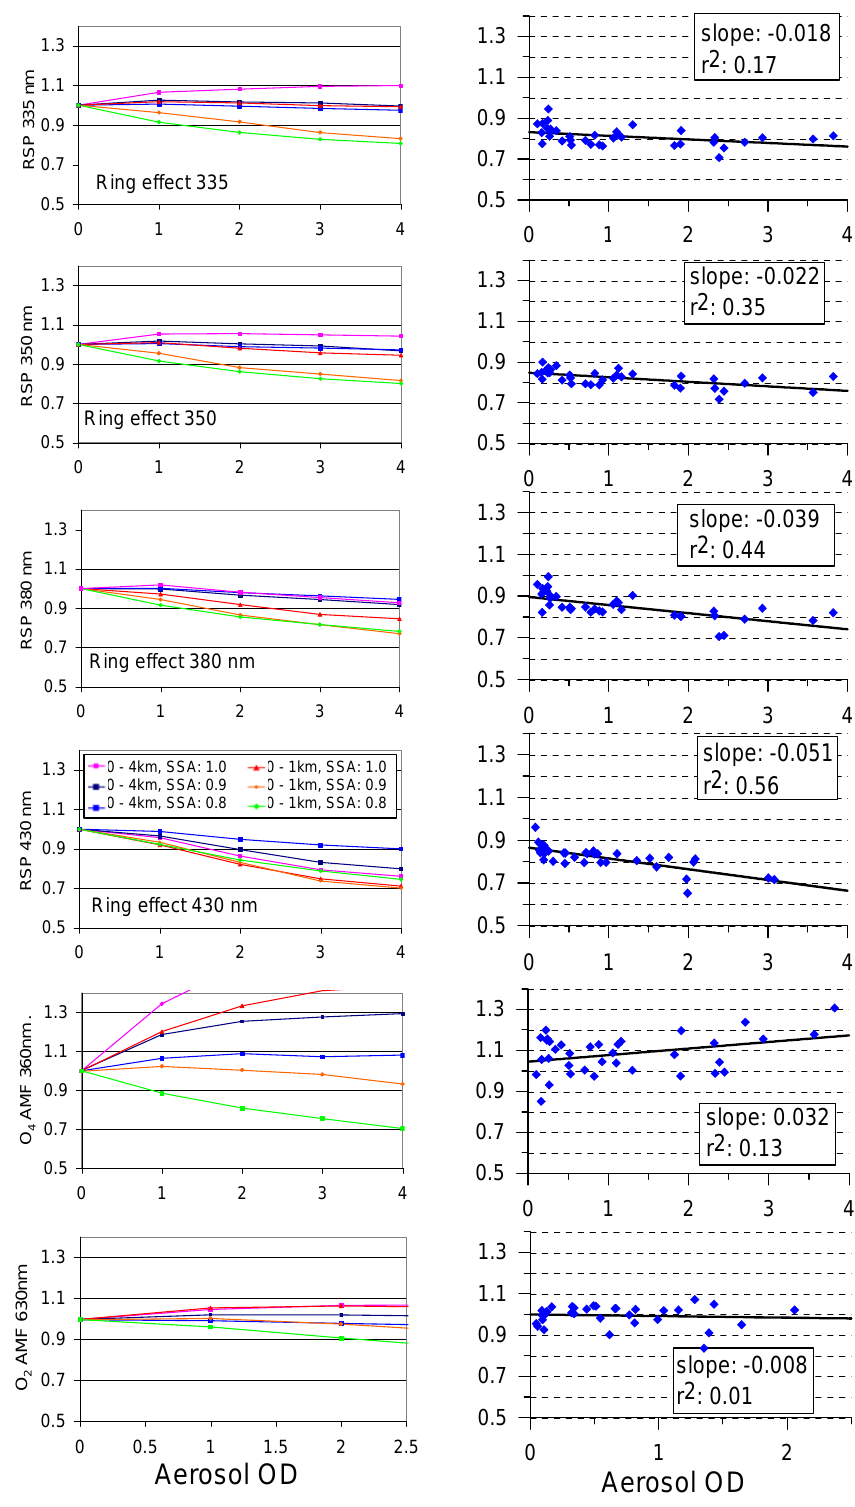
Fig. 12 Observed (right) and simulated (left) dependence of the Ring effect and the O Fig. 12. Observed (right) and simulated (left) dependence of the Ring effect and the O 2 and O 4 absorptions on the AOD. The data are absorptions on the AOD. The data are normalised to model results for an AOD of 0 (see text). normalised to model results for an AOD of 0 (see text). The calculations are performed for SZA of 30 ◦ and a viewing angle of − 90 ◦ (nadir). The calculations are performed for SZA of 30° and a viewing angle of -90° (nadir). The The aerosol asymmetry parameter was assumed to be 0.68. For 630nm the surface albedo was set to 10%; for all other wavelengths it was aerosol asymmetry parameter was assumed to be 0.68. For 630 nm the surface albedo was set set to to 10%; for all other wavelengths it was set to 5%.